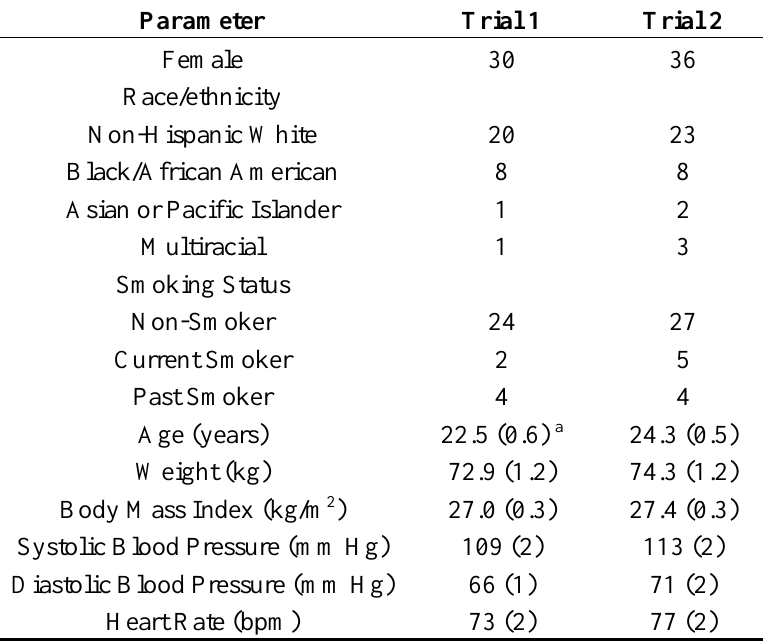
Table 3. Subject characteristics at